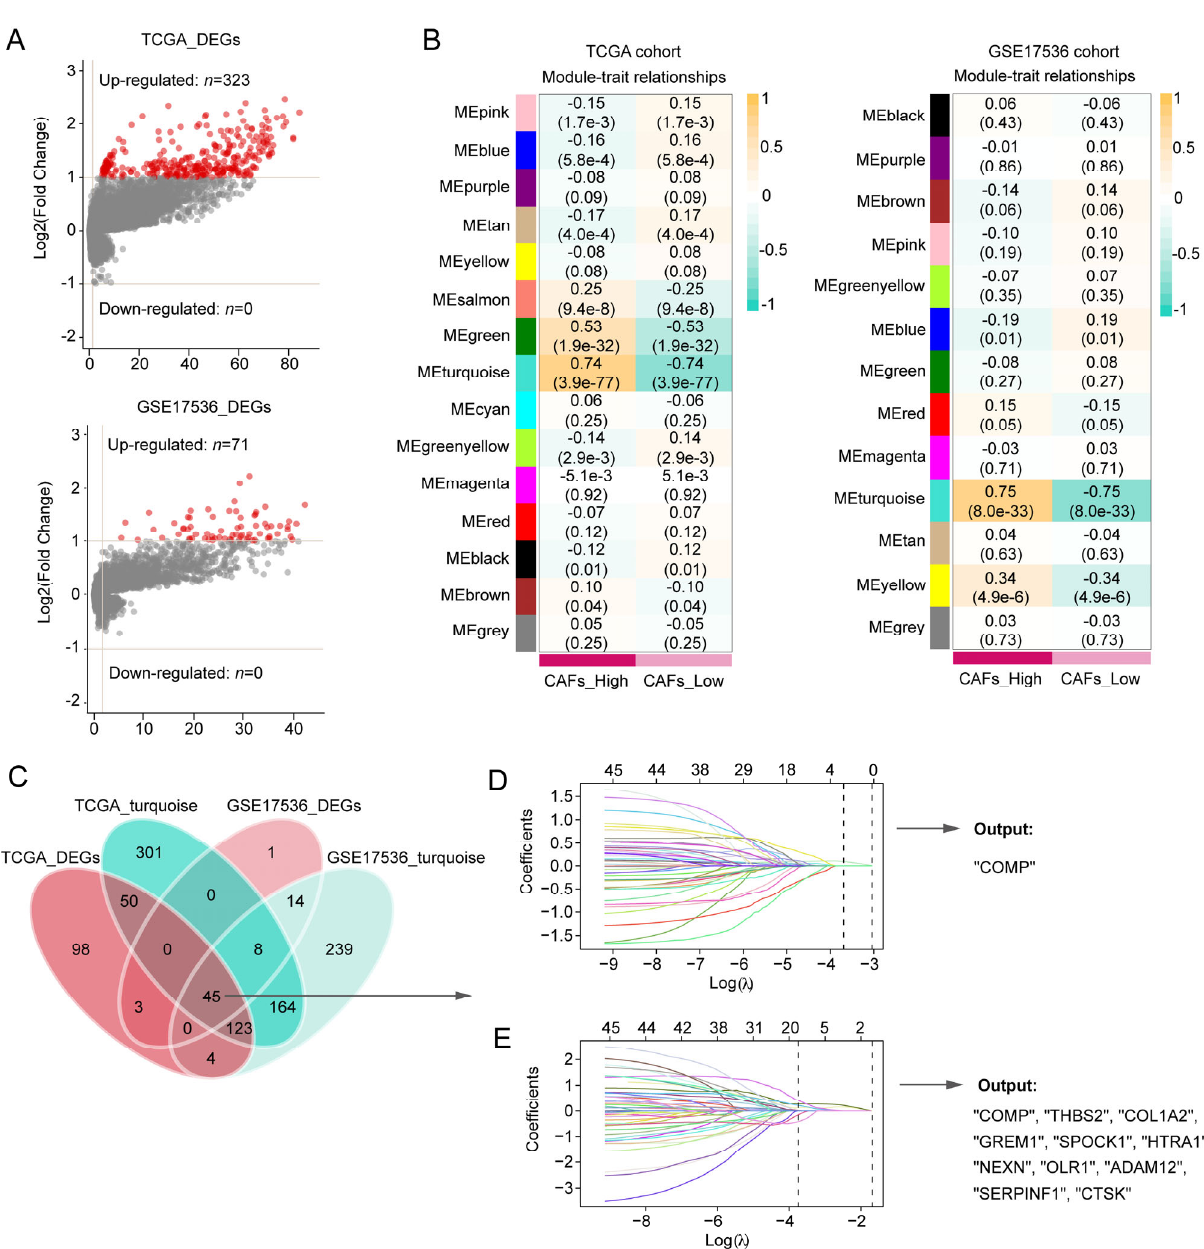
Figure 2. Screening for CAFs ‐ associated genes in the TCGA and GSE17536 datasets and identifica